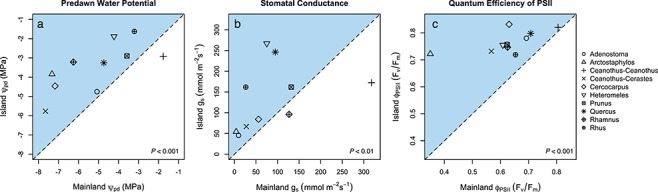
Predawn water potential (a), stomatal conductance (b) and quantum efficiency of PSII (c) measured during the peak of the summer dry season for 10 island–mainland species pairs. Each point represents one species pair. Dashed line is a 1:1 line. A majority of points above the 1:1 line (i.e. blue region) indicate more favorable water relations for island plants. P-values for paired statistical comparisons are depicted in the lower right corner of each plot.